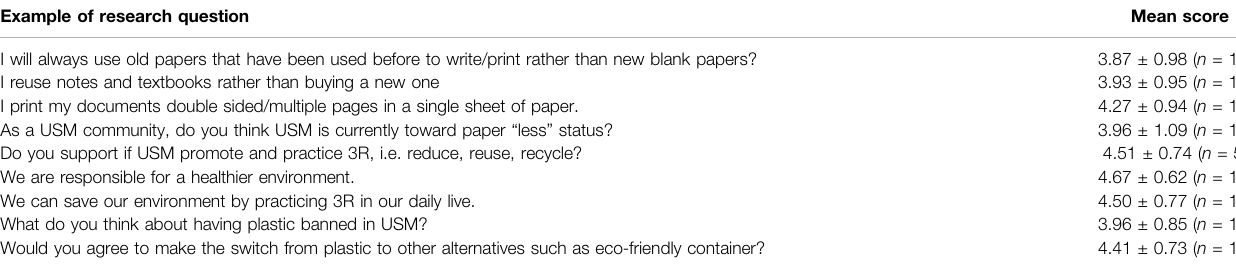
TABLE 2 | Example of research question pertaining to waste management carried out by undergraduate students from the course of WSU 101. Example of research question